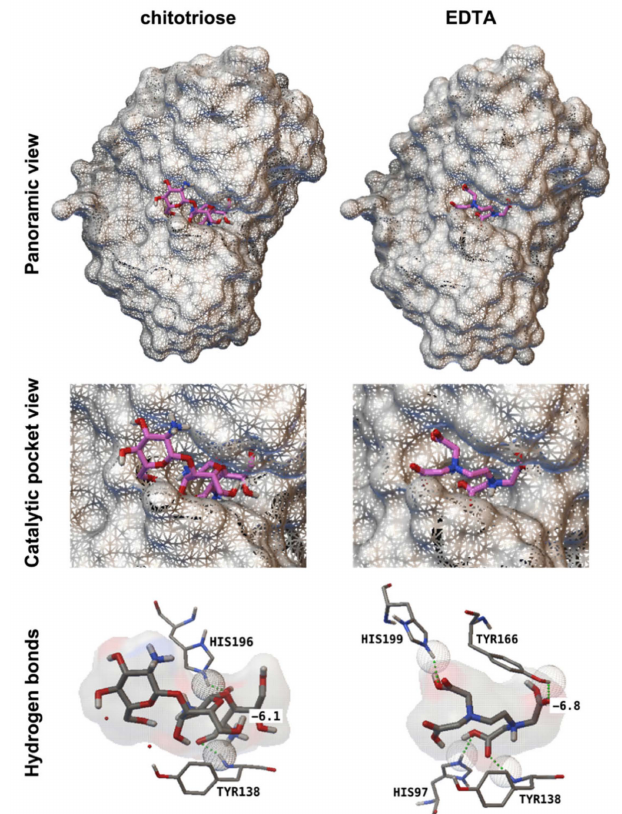
Figure 6. Molecular docking of EDTA and chitotriose to AnCDA. The molecular docking analysis was performed with AutoDock Vina using the 3D model of a CDA protein from Aspergillus nidulans (PDB 2y8u) and chitotriose (ChemSpider 108813) and EDTA (ChemSpider 5826) molecules. The results were visualized using AutoDock Tools. Panoramic view (upper images) of CDA protein with the chitotriose and the EDTA molecules docked in the proposed binding site (middle images). The hydrogen bonds (bottom row) between ligands and CDA residues are shown as green dots and wired spheres. EDTA is proposed to bind to AnCDA in the enzyme catalytic pocket (mapped by chitotriose docking and binding site analysis) via four hydrogen bonds that involve His97, Tyr138, Tyr166, and His199. The number indicates the affinity (kcal/mol) of the